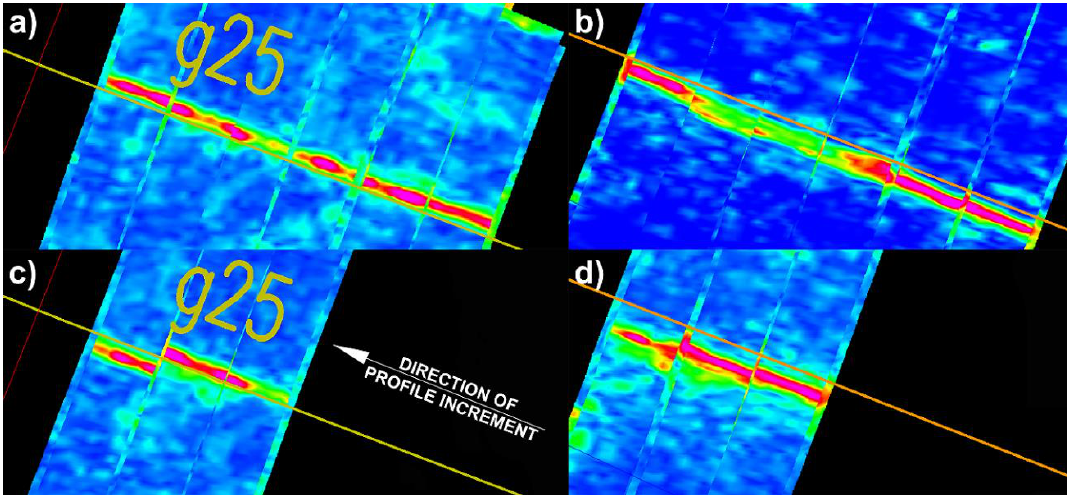
Figure 13. Analogical fragments of GPR echograms, positioned using ( a , b ) GPS PPS and ( c , d ) GPS.